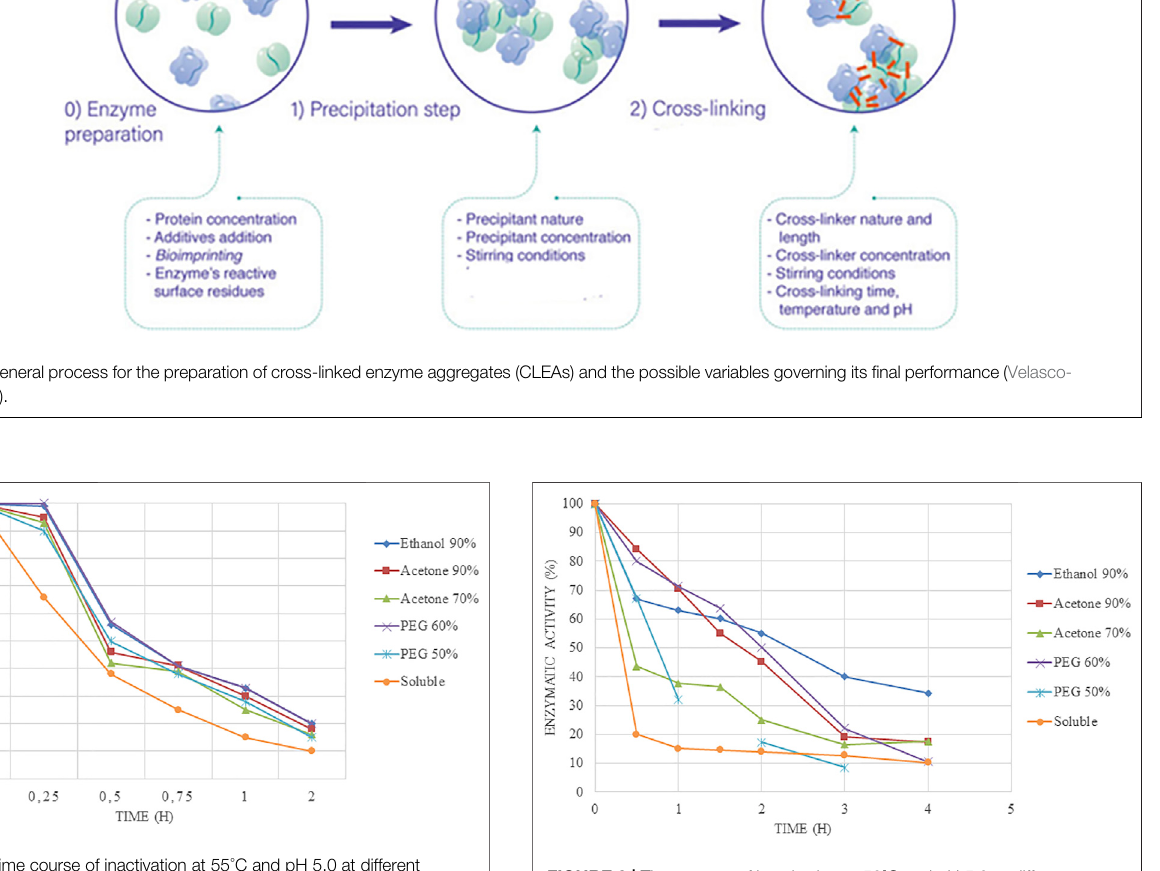
FIGURE 3 | Time course of inactivation at 50 ° C and pH 5.0 at different times of Alcalase ® -CLEAs using PEG, ethanol, and acetone as